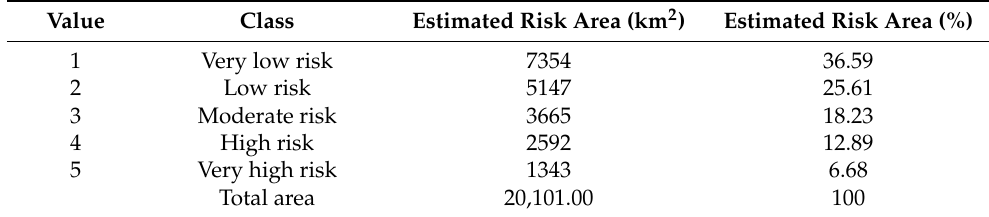
Table 4. Flood susceptibility risk classes and estimated area in square kilometers and